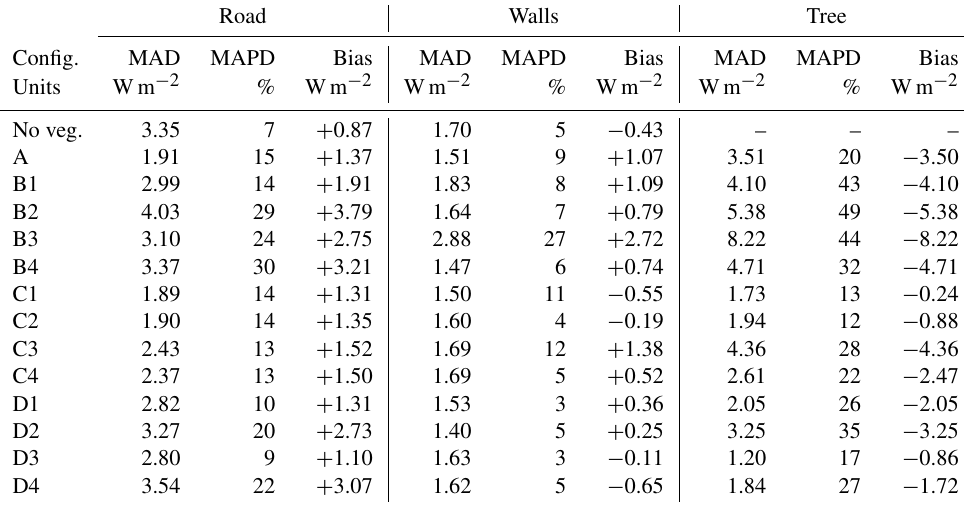
Table 5. Statistical scores for diffuse solar radiation received by surfaces before multiple reflections for summertime. Road Walls Tree Config. MAD MAPD